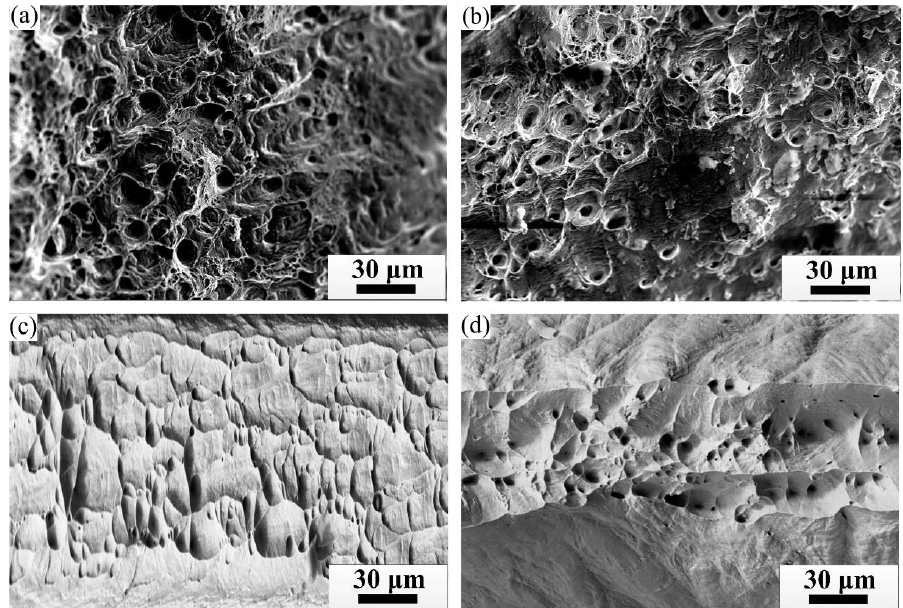
Figure 13. SEM fracture of CG strip undergoing different deformation. ( a ) 25%; ( b )5 0%; ( c ) 75%; ( d ) 98%. ( d )